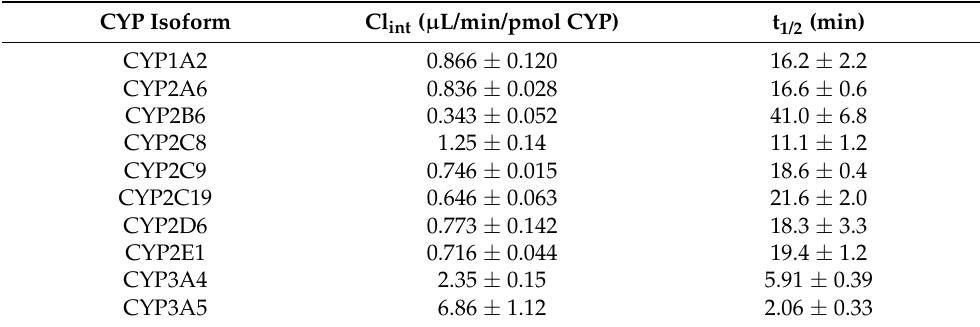
Table 9. The intrinsic clearance (Clint) and half-life (t1/2) of ZB716 incubated with individual recombinant human CYP isoforms (mean ± SD, n = 3).